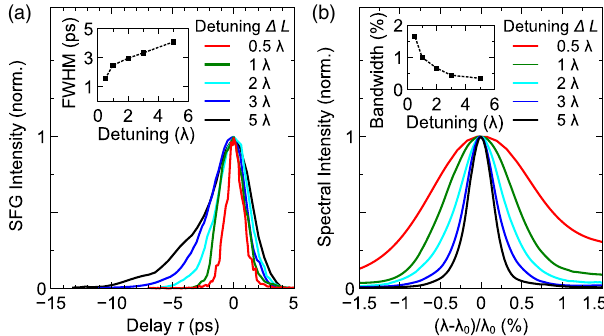
FIG. 4. FEL pulse profile dependence on cavity detuning Δ L . (a) Temporal shape I ð τ Þ of the micropulse measured by SFG cross-correlation and extracted FWHM duration (inset). (b) Spec- tral structure and relative bandwidth Δ λ = λ (inset); all data taken at a wavelength of λ 0 ¼ 10 μ